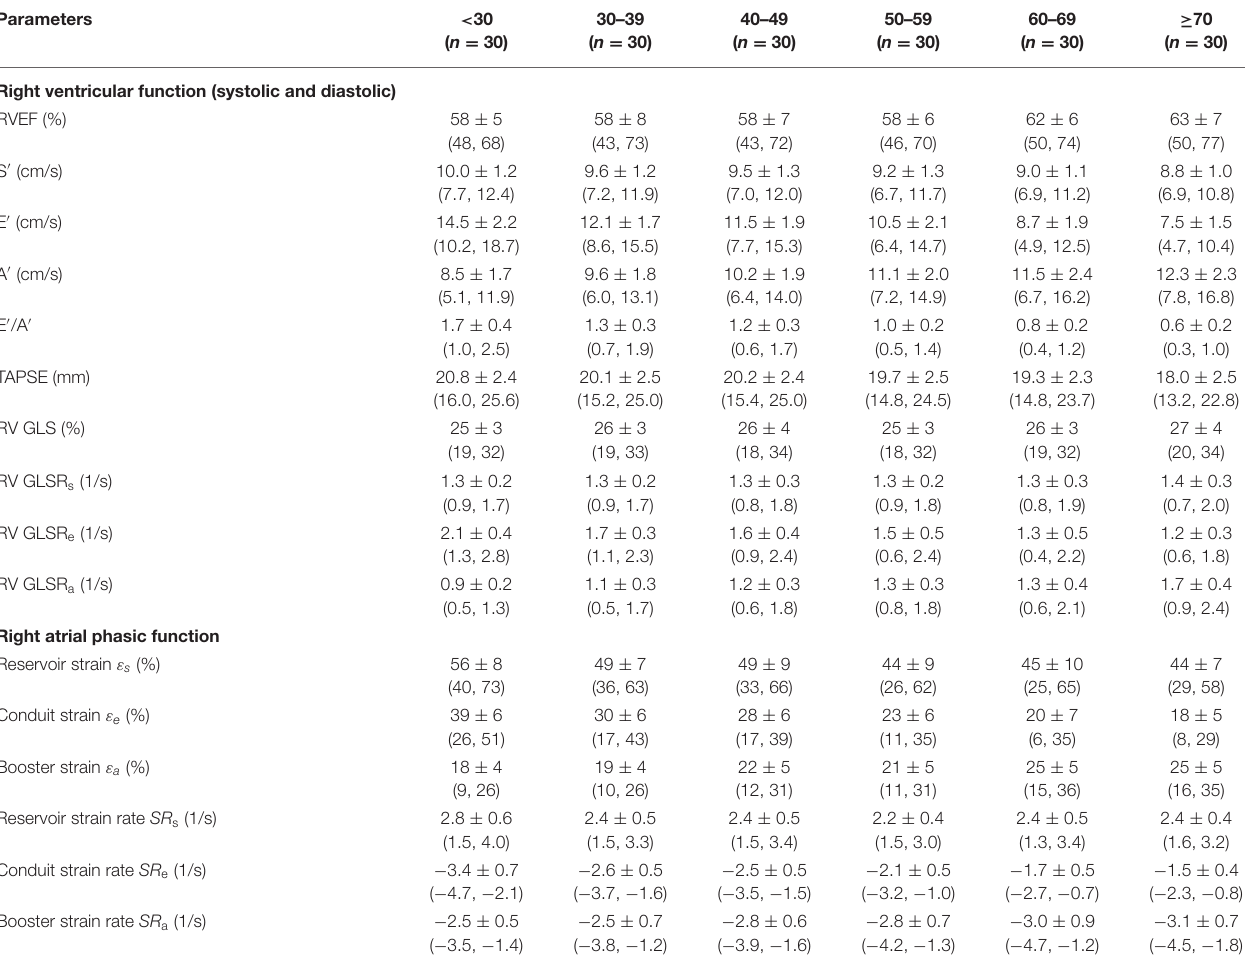
TABLE 3 | Females: right heart function parameters by age group [mean ± SD (reference range, lower/upper limits calculated as mean ± 1.96 · SD)].